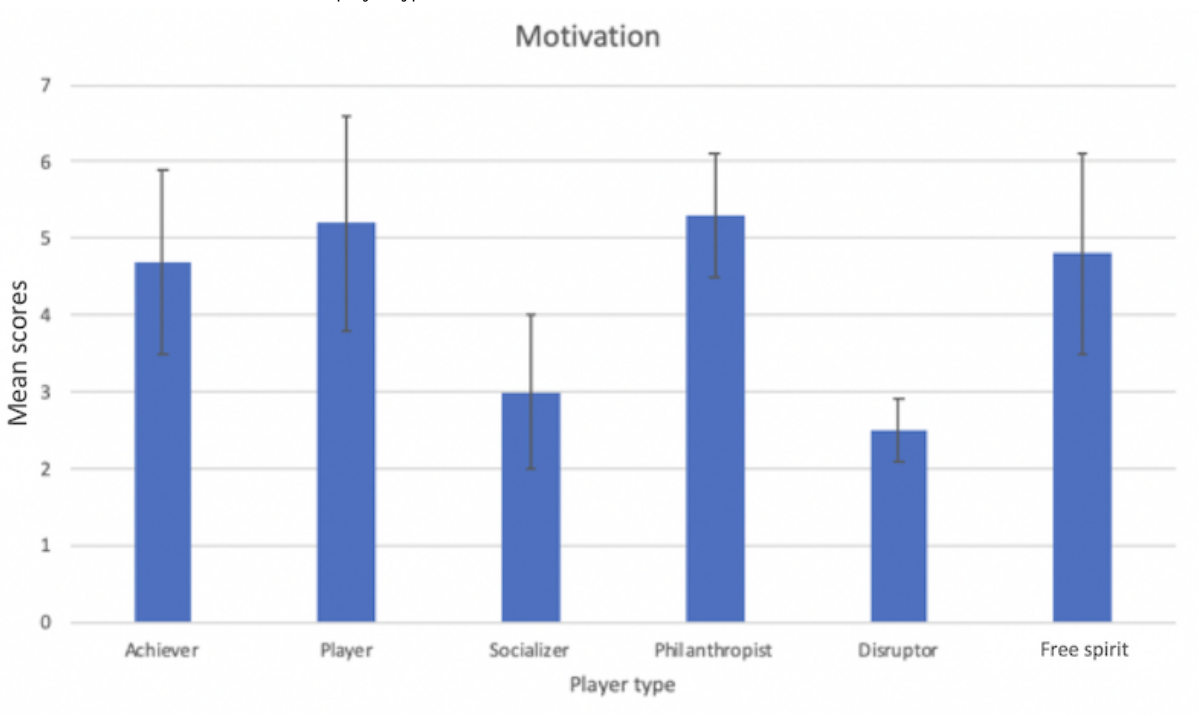
Figure 11. Overall motivation for different player